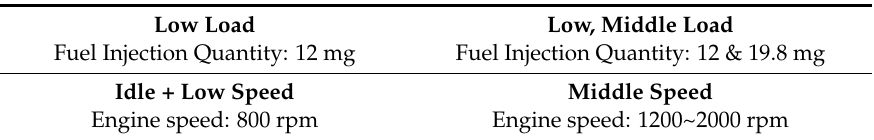
Table 1. Operating points on map in R-engine.